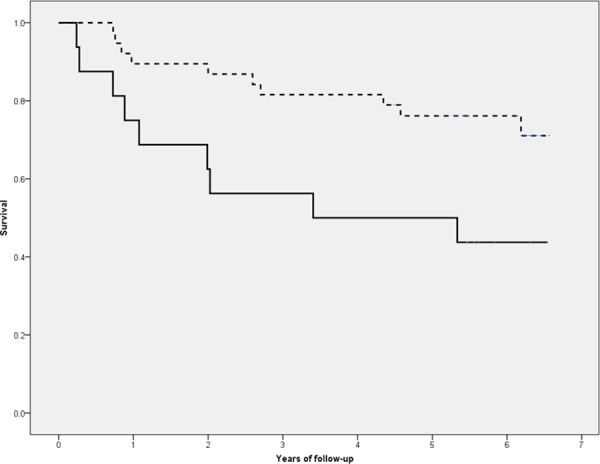
Survival curves in normohydrated and overhydrated patients._ _ _ normohydrated group; ____ overhydrated group.